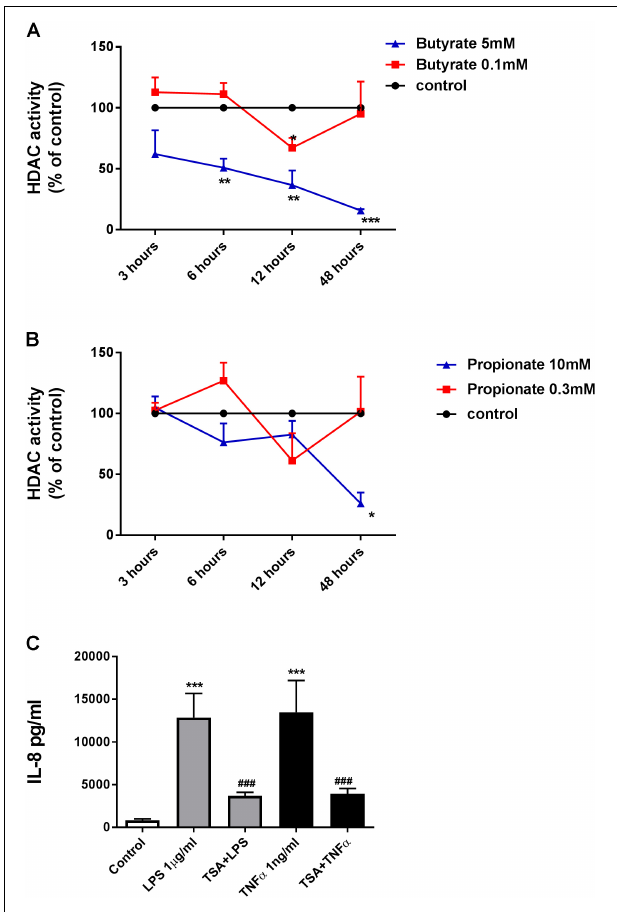
FIGURE 4 | Butyrate, propionate, and TSA inhibited HDACs activity in HUVEC. (A) and (B) HDACs activity were inhibited in HUVEC by treatment of butyrate and propionate. The results were normalized using the control as 100%. (C) TSA inhibited IL-8 production in HUVEC. N = 3–4 for each group, ∗ p < 0.05, ∗∗ p < 0.01, ∗∗∗ p < 0.001 compared with control group; ### p < 0.001 compared with LPS or TNF α